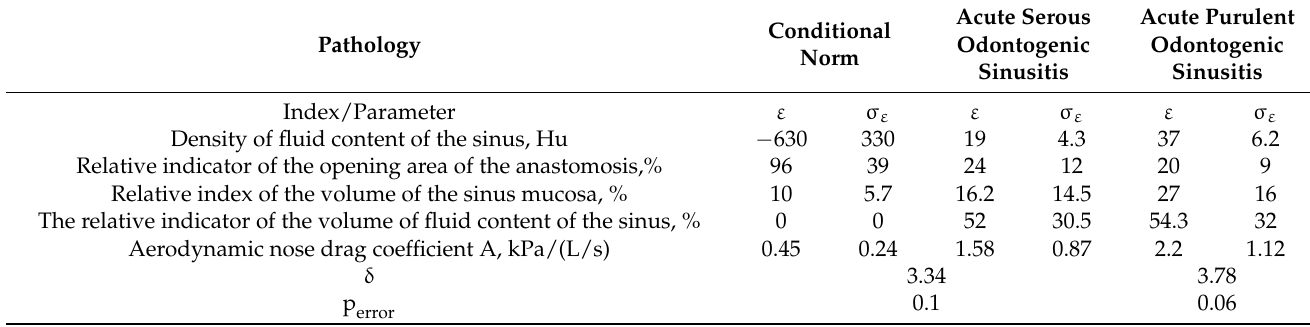
Table 1. Comparison (control) of the norm with acute serous odontogenic sinusitis and acute purulent odontogenic sinusitis. Pathology